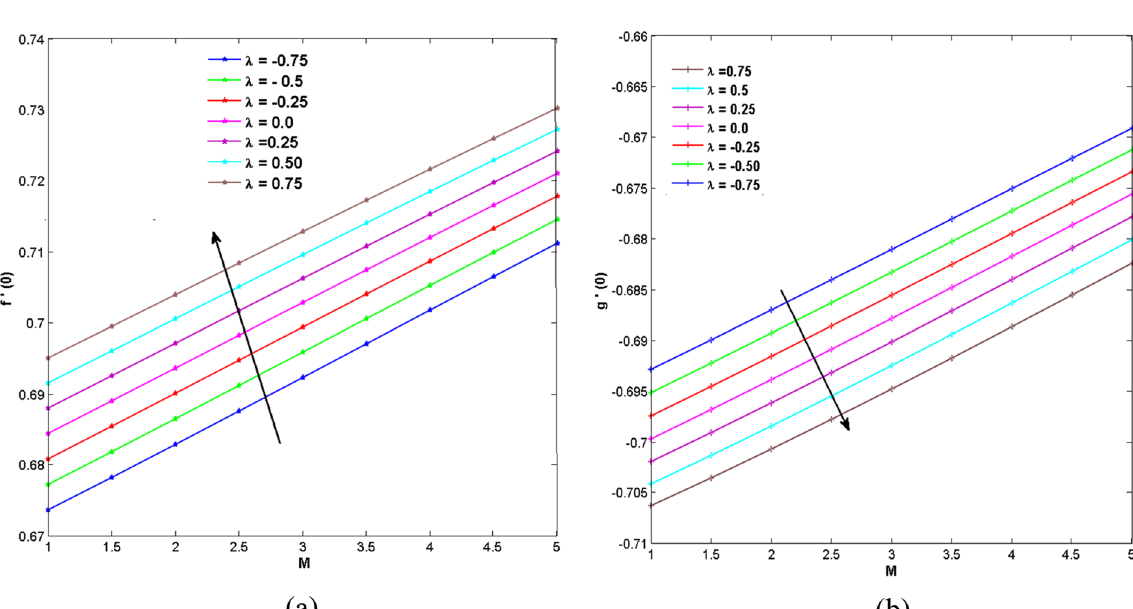
Figure 14. Profile of f ′ ( 0 ) and g ′ ( 0 ) versus M for increasing values of (cid:31)